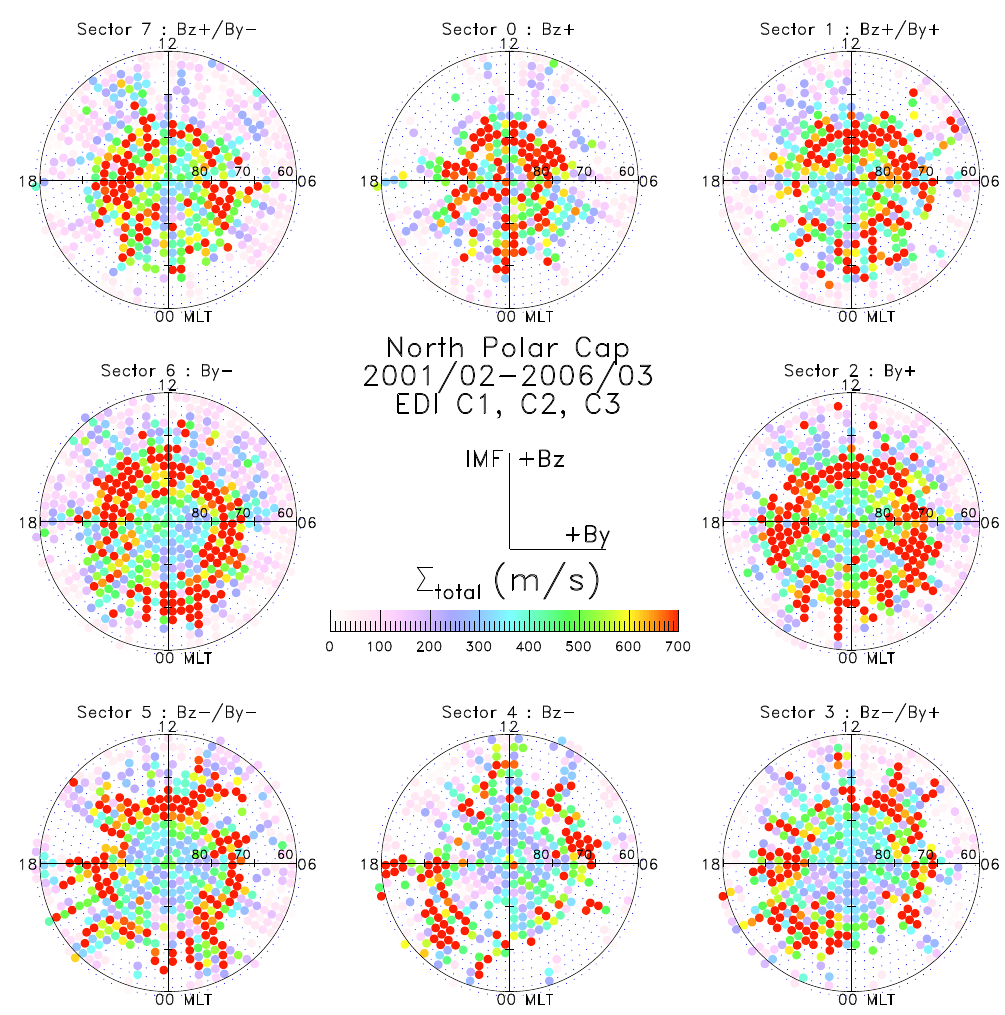
Fig. 5. Standard deviation of the total vector variation [ms − 1 ] of EDI drift vectors mapped to the Northern high latitude ionosphere for the time interval from Feb 2001 to Mar 2006. As in Figs. 3 and 4, each circular panel shows magnetic local time (MLT) versus magnetic latitude with 60 ◦ at the outer border. The color bar indicates the magnitude of the standard deviation, which is calculated for each bin individually, based on at least three valid mapped drift vectors within the bin.